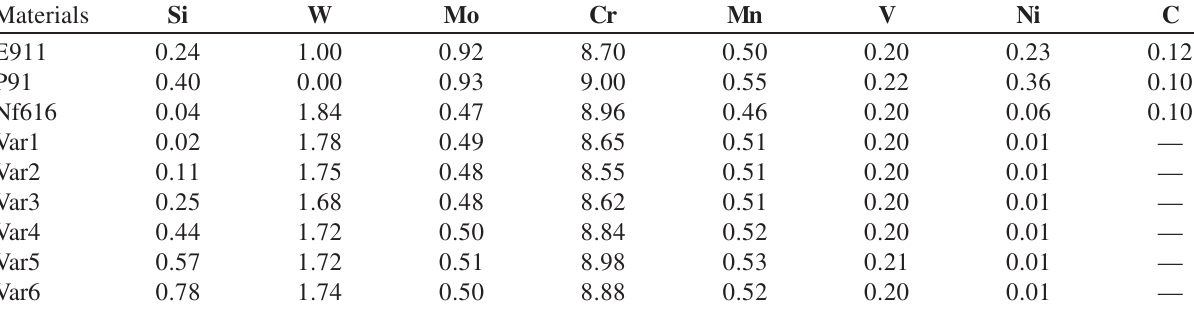
Table 1 . Composition of the Steels Investigated (in